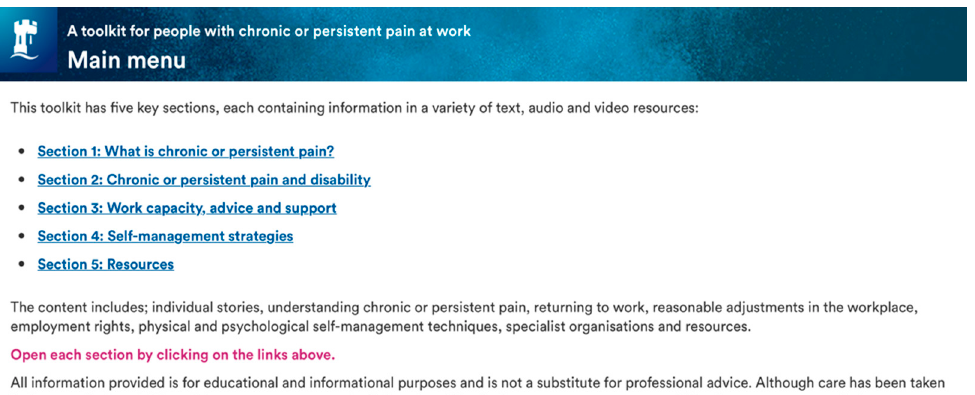
Figure 4. Example screenshot from the PAW Toolkit† (Version 1.0, 2021). (https://www.nottingham. ac.uk/toolkits/play_24452) (accessed on 17 November 2021). † see [54] to access toolkit, credits, embedded links and additional